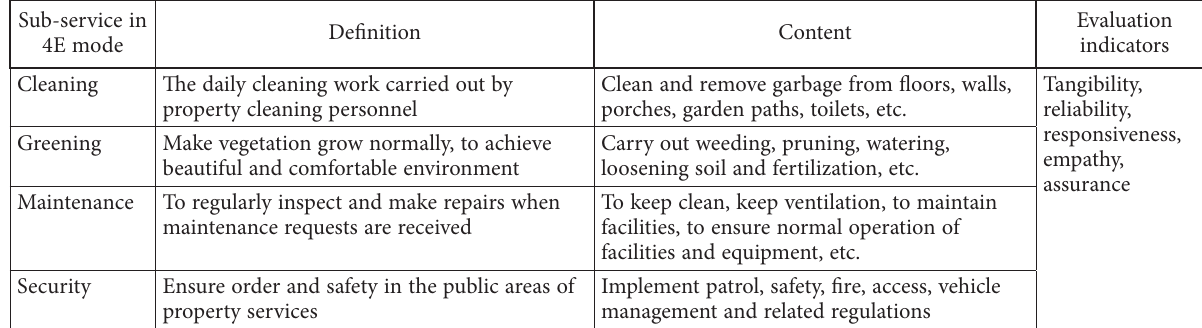
Table 1. Summaries of definition, content and indicators of the 4E